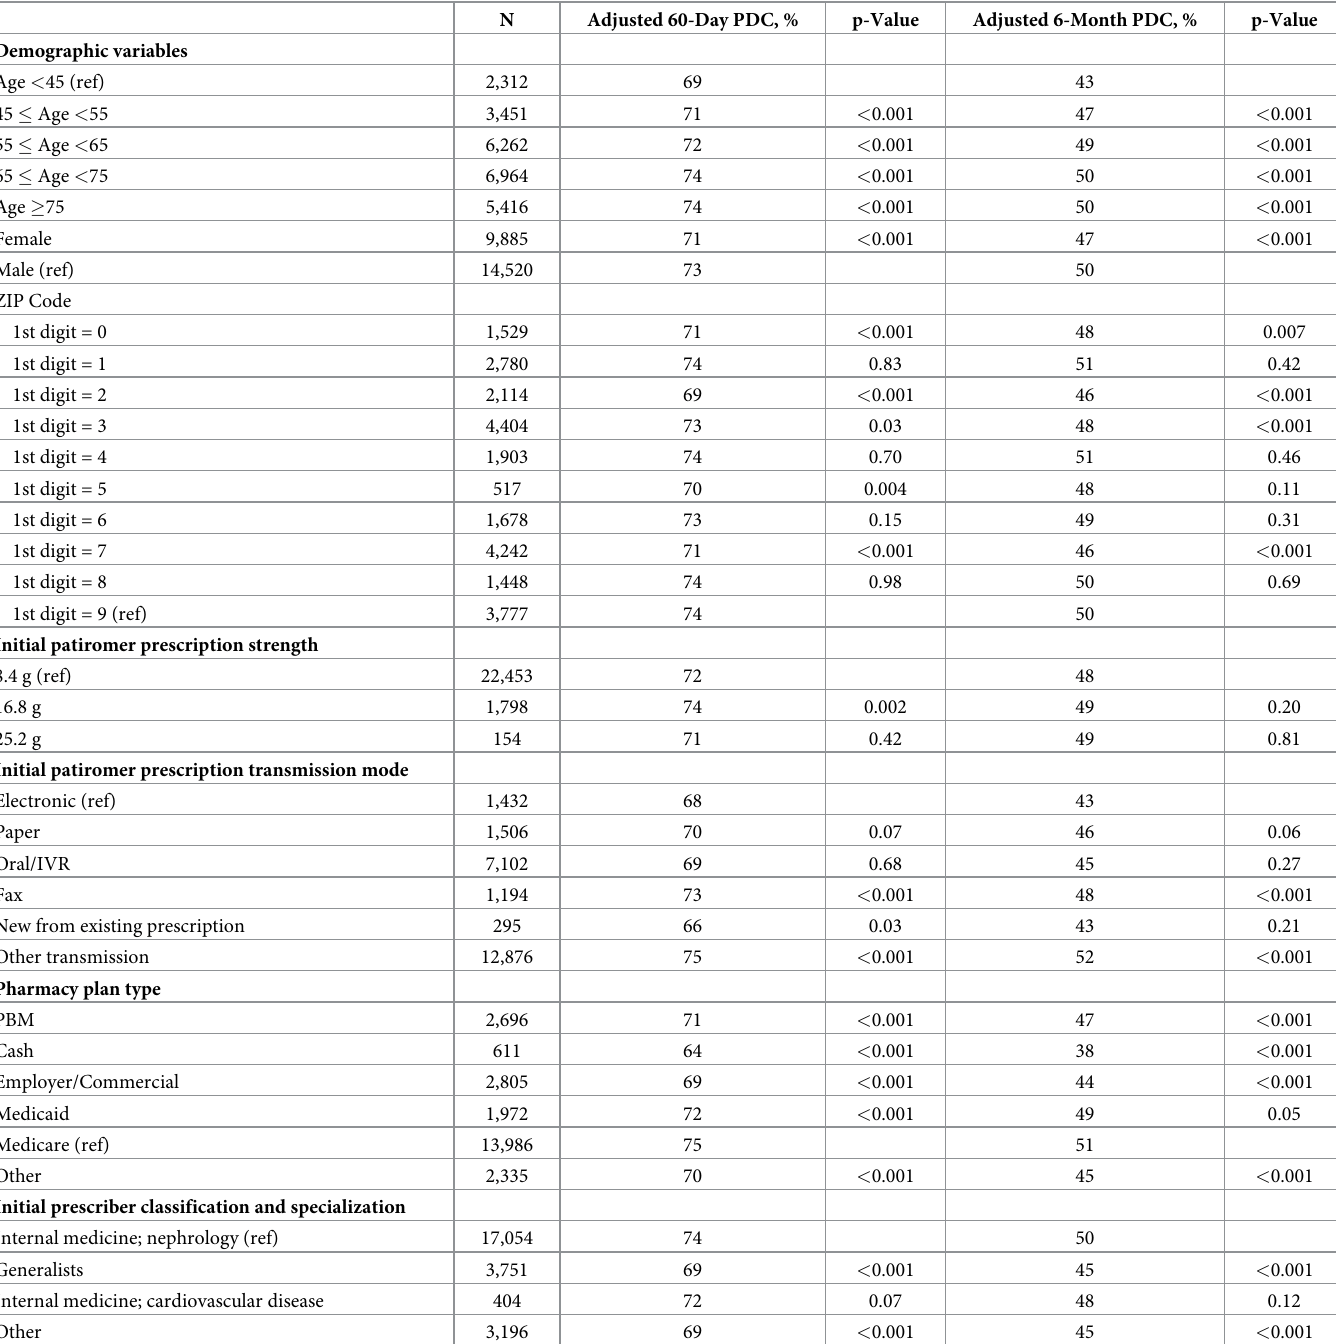
Table 2. 60-day and 6-month regression-adjusted proportion of days covered (N =